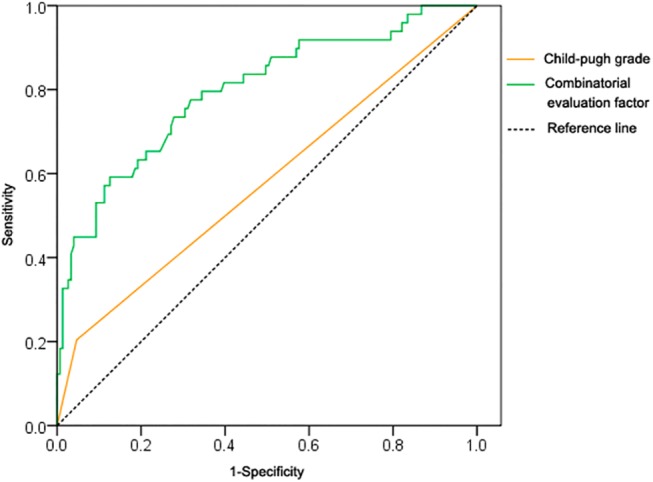
ROC curve of the combinatorial evaluation factor and Child-Pugh in estimating postoperative liver dysfunction.